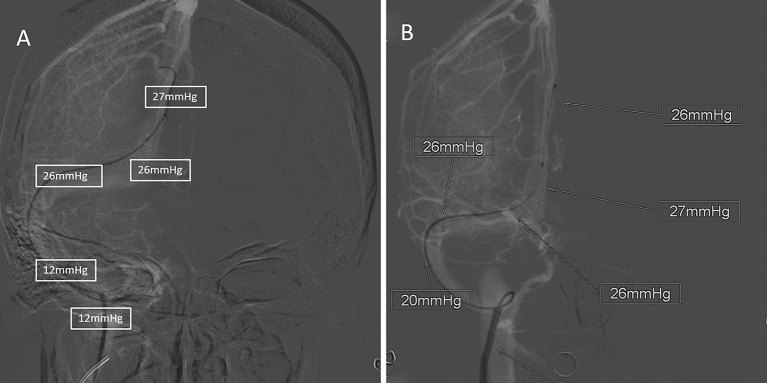
A typical 32-year-old female patient with IIH. All pressure outcomes were immediately marked by the imaging technician. (A) was the recording of pressure outcome under awake setting, and (B) was the recording of pressure outcome under GA.